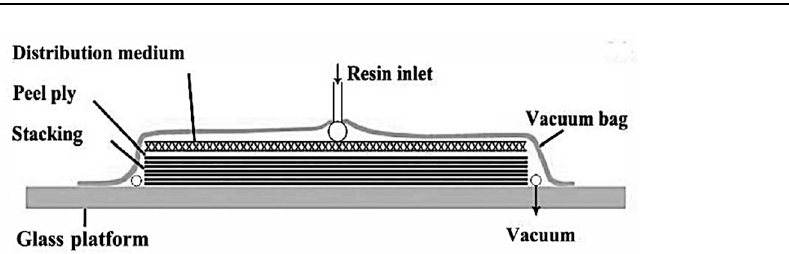
Figure 2. Schematic drawing of Vacuum-Assisted Resin Infusion (VARI) fabrication process for composite laminates.